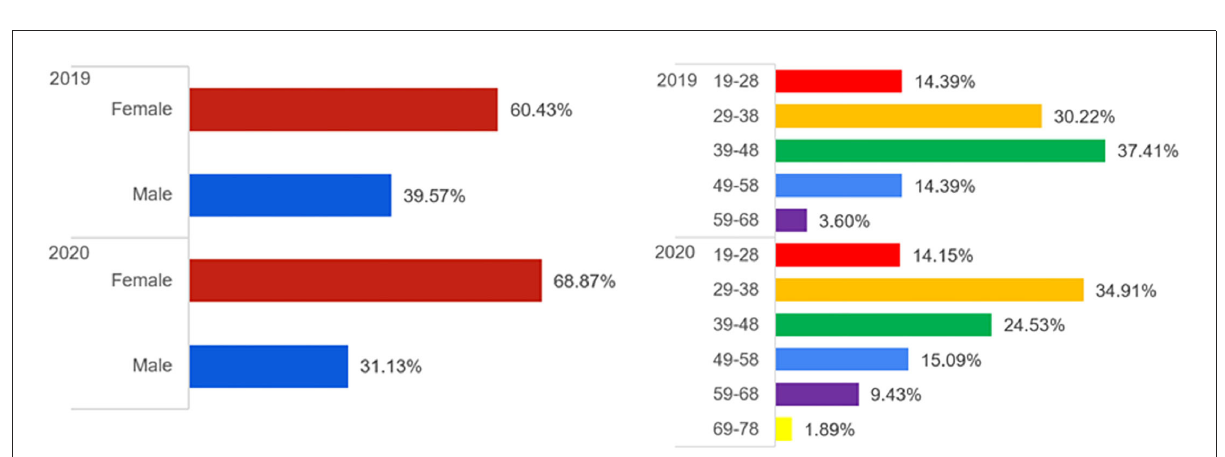
FIGURE1 Sample structure by gender and